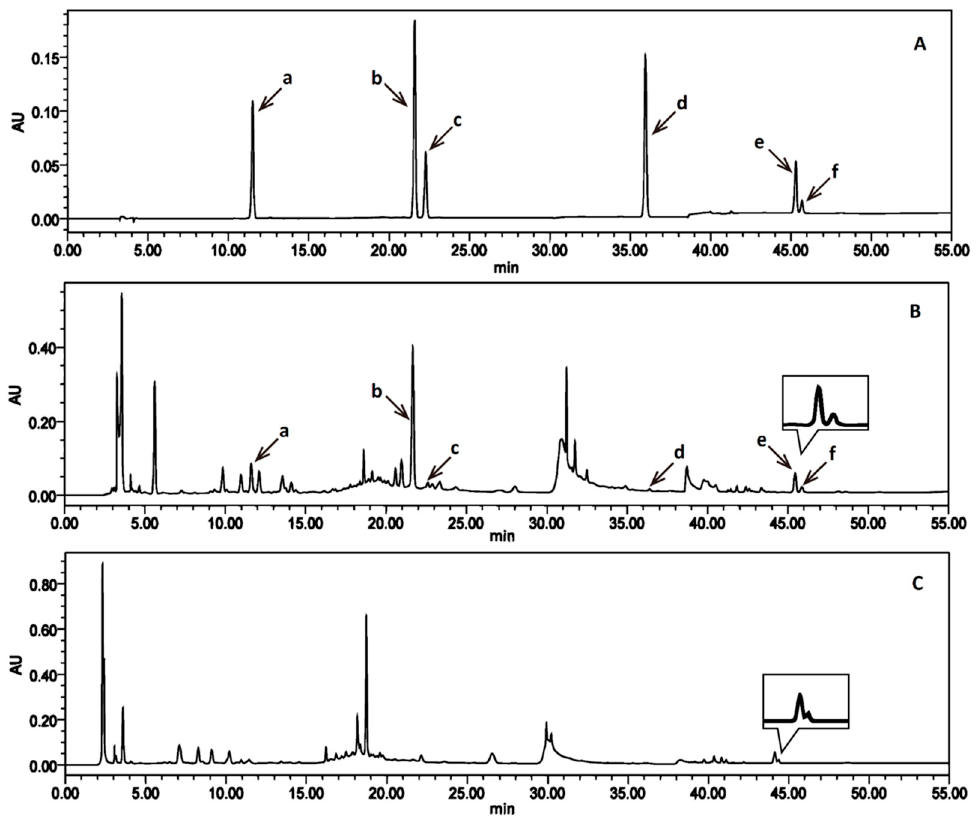
Figure 1. Chromatograms of reference substances using the C 30 -column ( A ); Erzhiwan (EZW)-3 sample using the C 30 -column ( B ); EZW-3 sample using the C 18 -column ( C ). Letters a–f represent salidroside (a), specnuezhenide (b), ligustroflavone (c), wedelolactone (d), oleanolic acid (e), and ursolic acid (f), respectively.